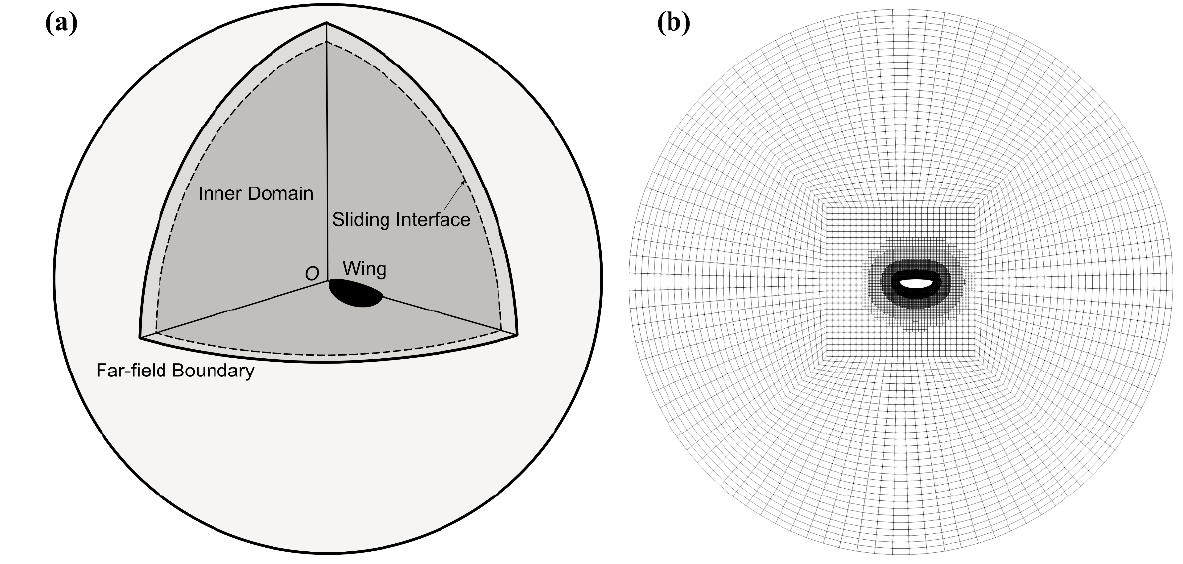
Figure 3. ( a ) Simulation domain; and ( b ) planform view of an example mesh distribution.